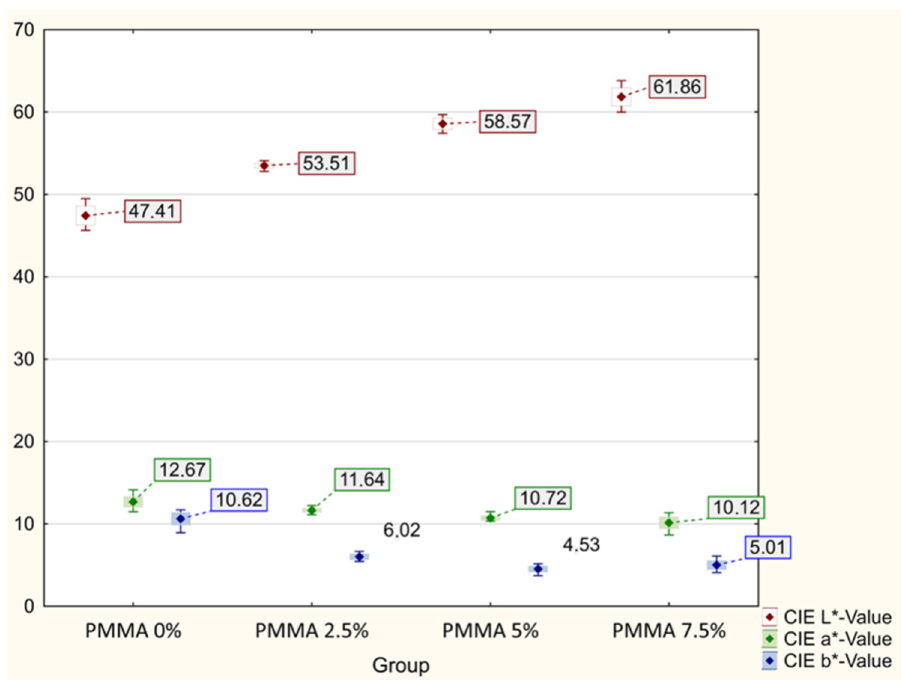
Figure 1. Comparison of mean values in CIE L*a*b* color space of modified and unmodified PMMA.